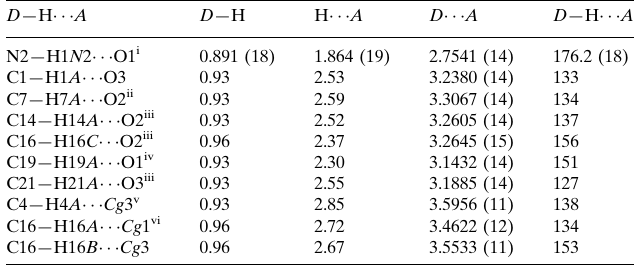
Hydrogen-bond geometry (A˚ , (cid:4)